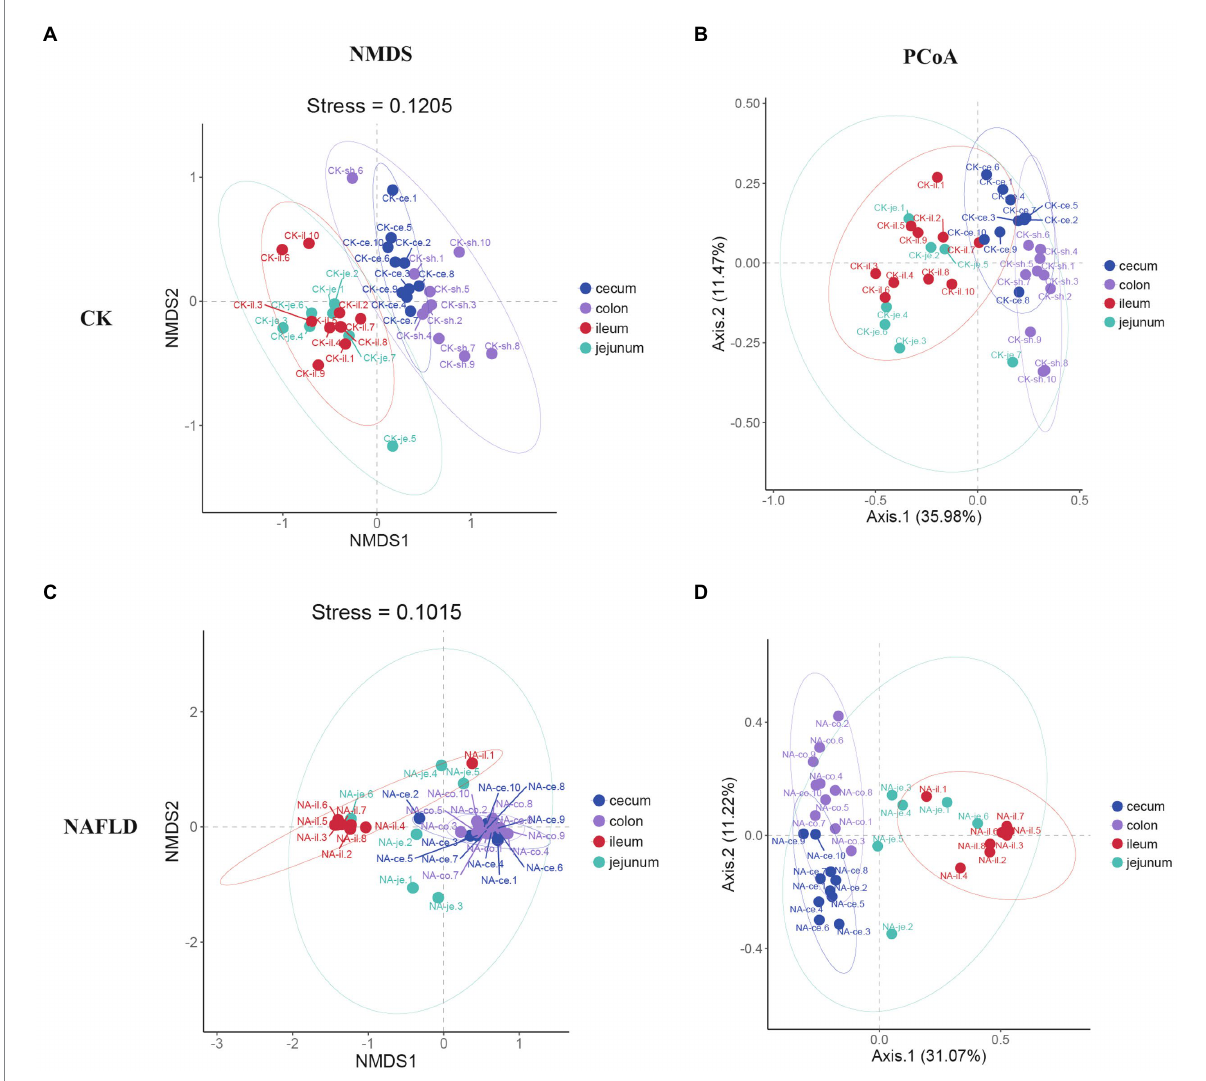
FIGURE 5 Beta diversity analysis of the jejunum, ileum, cecum, and colon in the same group assessed by NMDS and PCoA based on Bray-Curtis distance. (A,B) CK group, and (C,D) NAFLD